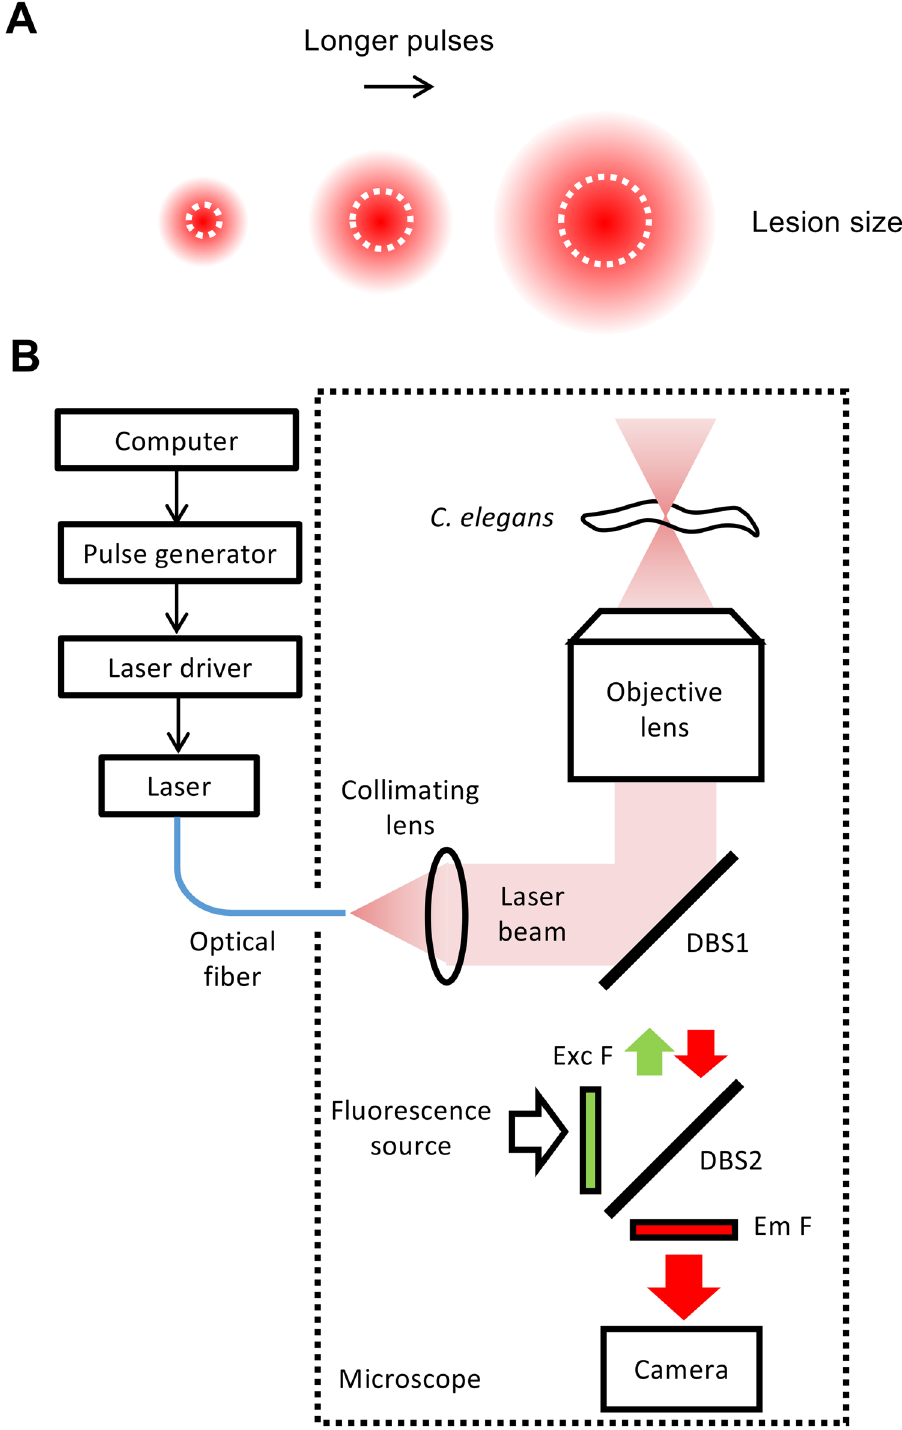
Figure 1. Thermal ablation system. ( A ) Basic principle of thermal ablation with variable lesion size. Increased duration and/or number of pulses increases the total amount of heat delivered, thereby increasing the spatial extent of thermal damage. ( B ) Infrared laser ablation system. A computer and pulse generator trigger the infrared laser to produce pulses of tunable length. A microscope objective focuses the laser beam within the worm, producing localized thermal